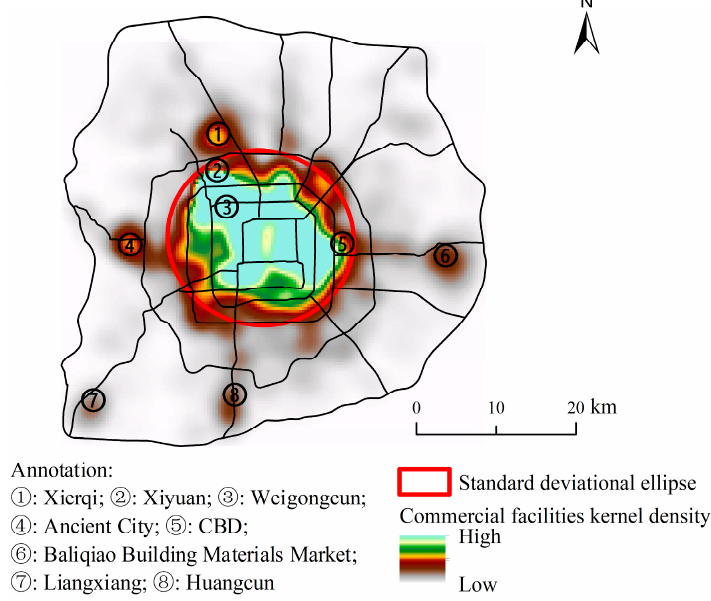
Figure 4. Kernel density and standard deviational ellipse analysis of commercial facilities.